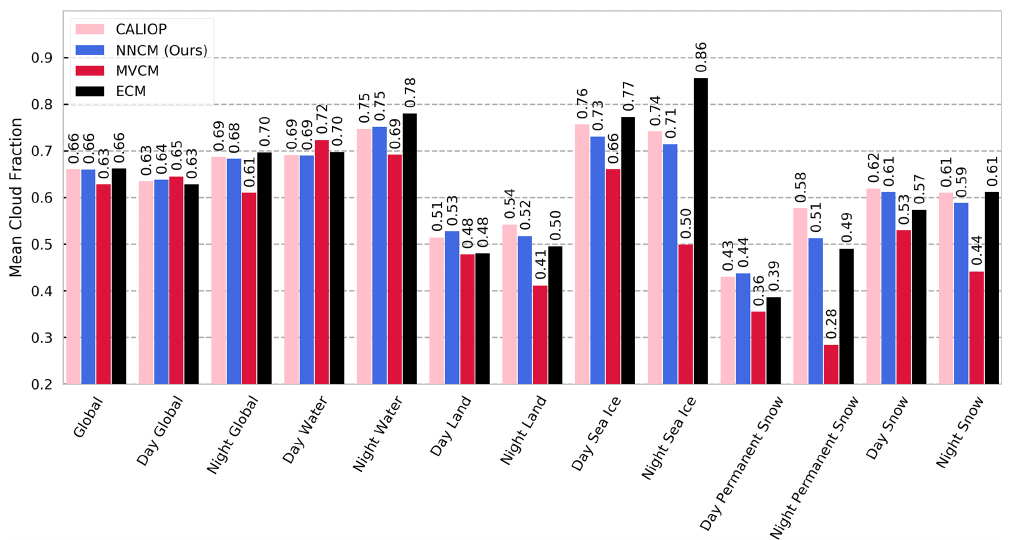
Figure 3. Mean cloud fraction for the 2019 unfiltered testing dataset. Each bar grouping from left to right shows the value from the CALIOP 1km product, the NNCM, MVCM, and ECM. Time of day and surface categorizations are described in the main text. Table 5. BACC, TPR, and TNR calculated for each cloud mask over different surfaces during day and night for the filtered dataset. Colloca- tion counts do not sum to the count listed in the “All” row because sea ice collocations are also counted in the water category, and the two snow categories are also counted in the land category. Cloud fraction is calculated from the CALIOP collocations. NNCM ECM MVCM Cloud Number fraction (million)